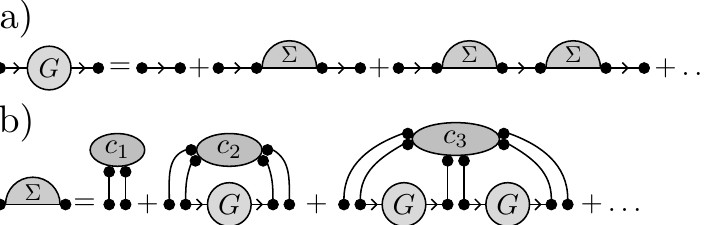
Figure 2 . Some exemplary planar diagrams in a model with a quartic term g the Green’s function. All diagrams (except for the (cid:12)rst) are